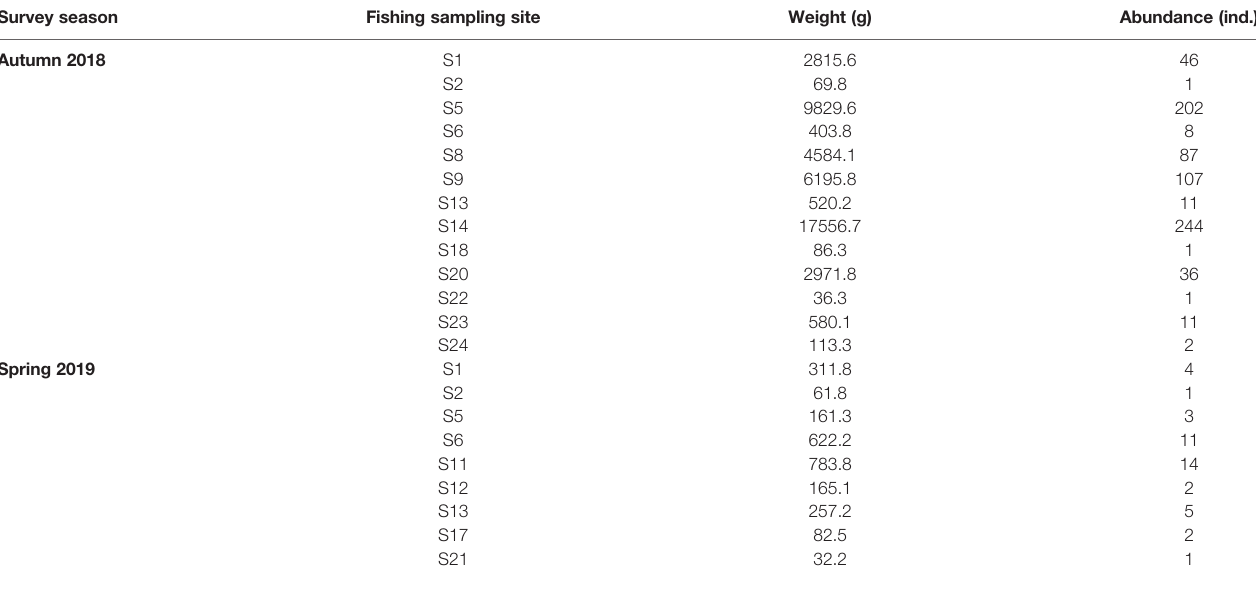
TABLE 2 | Catches of Larimichthys crocea in fi shing survey